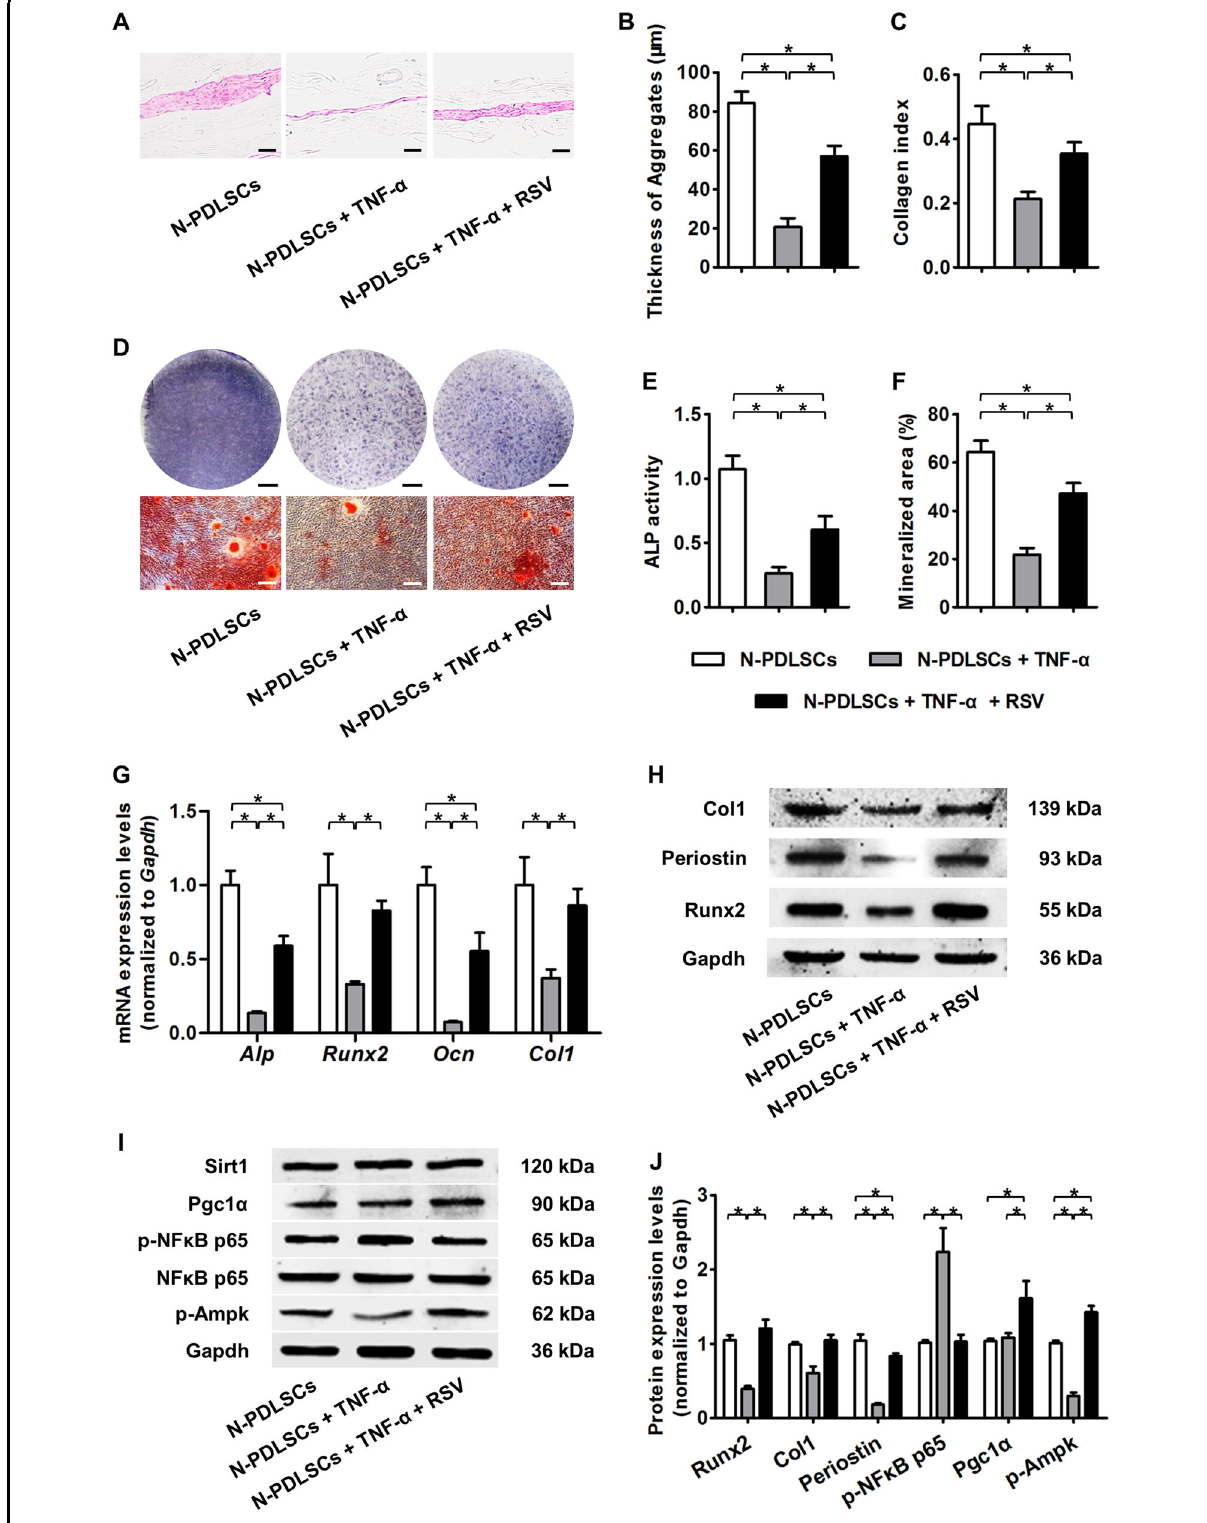
Fig. 2 (See legend on next